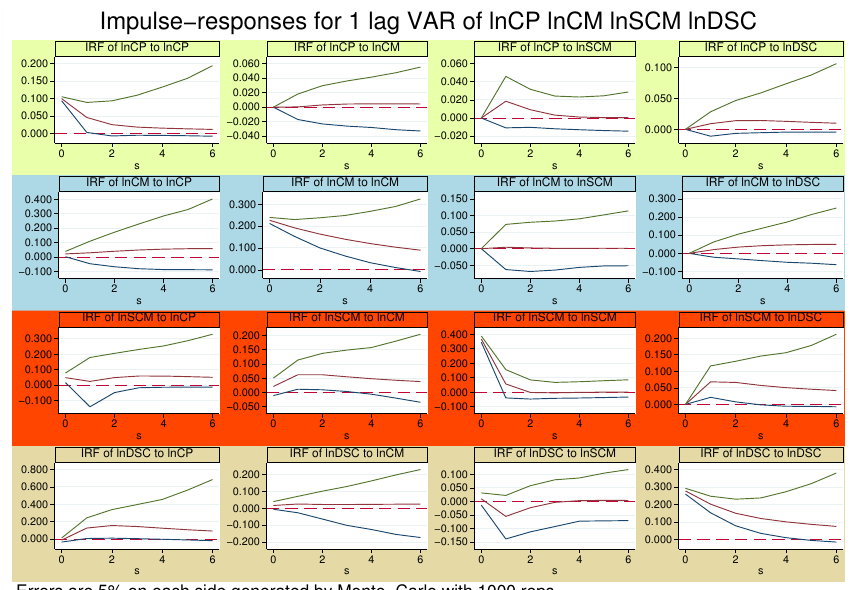
Errors are 5% on each side generated by Monte−Carlo with 1000 reps Figure 8. The first row (in light green) indicates, respectively, the impulse response of corporate performance to itself (lnCP), corporate management (lnCM), supply chain management (lnSCM), and debt servicing capacity (lnDSC); the second row (in light blue) indicates, respectively, the impulse responses of corporate management to corporate performance (lnCP), itself (lnCM), supply chain management (lnSCM), and debt servicing capacity (lnDSC); the third row (in orange) indicates, respectively, the impulse responses of supply chain management on corporate performance (lnCP), corporate management (lnCM), itself (lnSCM), and debt servicing capacity (lnDSC); and the fourth row (in khaki) indicates, respectively, the impulse responses of solvency to corporate performance (lnCP), corporate management (lnCM), supply chain management (lnSCM), and itself (lnDSC). (4) As shown in Figure 9, the impulse response of corporate performance to itself